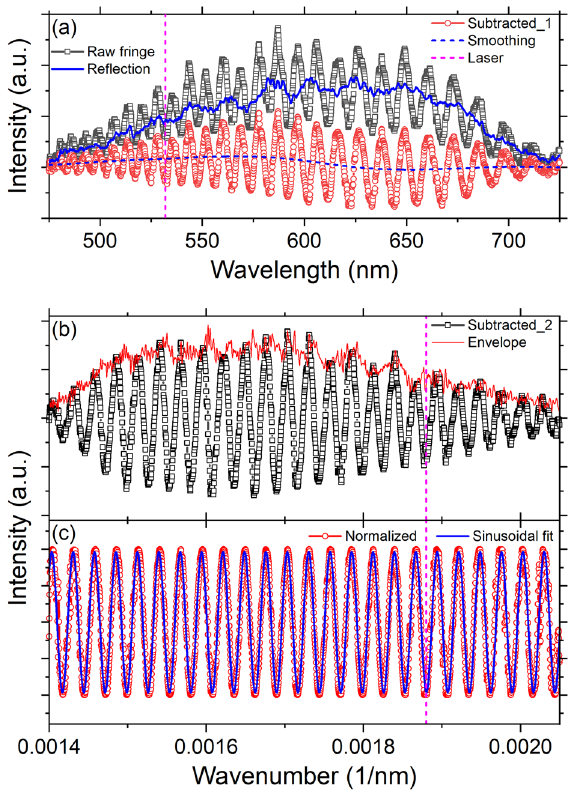
Figure 3. Analysis of the interference fringe spectrum obtained from the empty DAC with a white light. ( a ) The reflection spectrum from the flat gasket surface (blue line) is subtracted from the raw fringe spectrum (black square). In the subtracted spectrum (red circle), the residual intensity offset is determined with a smoothing method (blue dashed) and subtracted. ( b ) The envelope of the zero-mean spectrum (black square) is obtained with the Hilbert transform (red line). ( c ) The oscillation period ( �ν ) is obtained through a sinusoidal fitting (blue line) of the intensity-normalized spectrum (red circle). Pink dotted vertical line indicates the laser wavenumber ( ν L